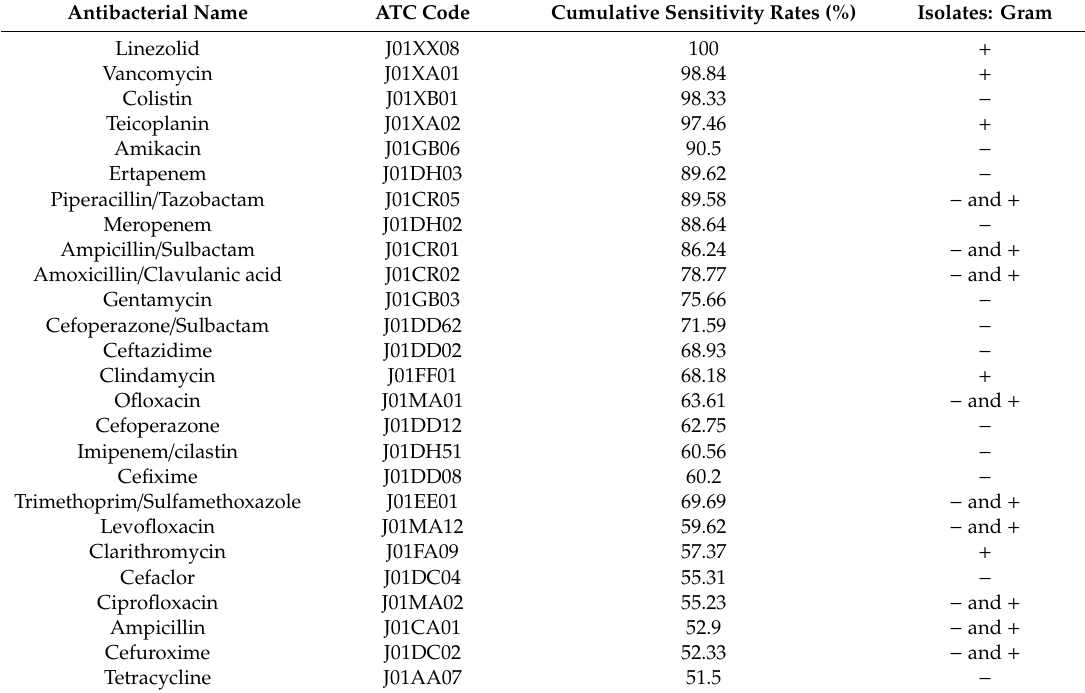
Table 5. Sensitivity rates of tested antibiotics (according to cumulative